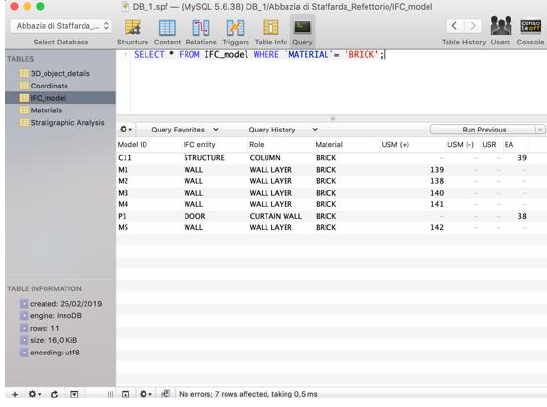
Figure 5. DBMS concerning IFC objects and stratigraphy